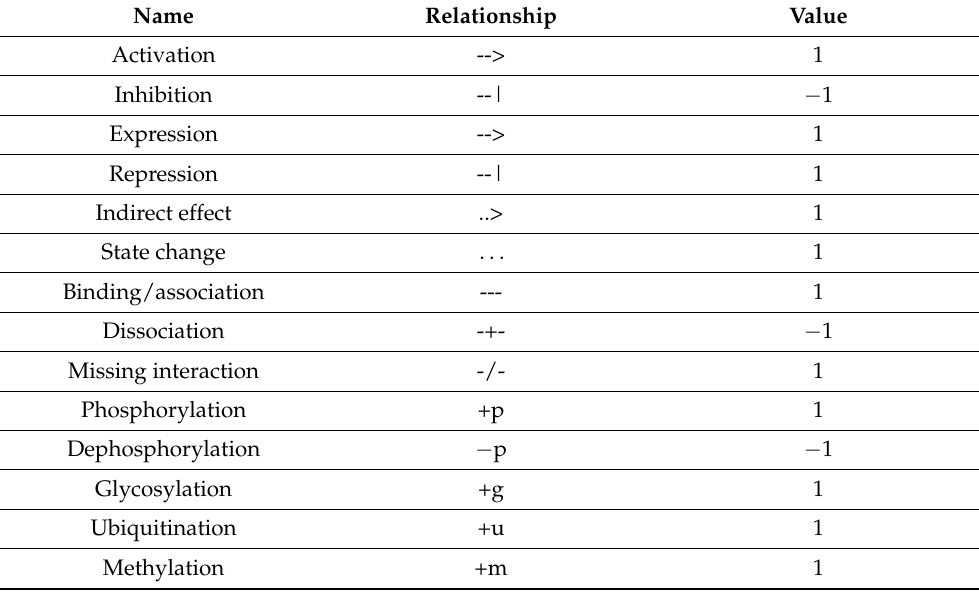
be active. KEGG grouped into two relationship types — induction (defined as 1) and inhibition (de- fined as − 1) [32,33]. Table 3. Between-node relationships in pathways.